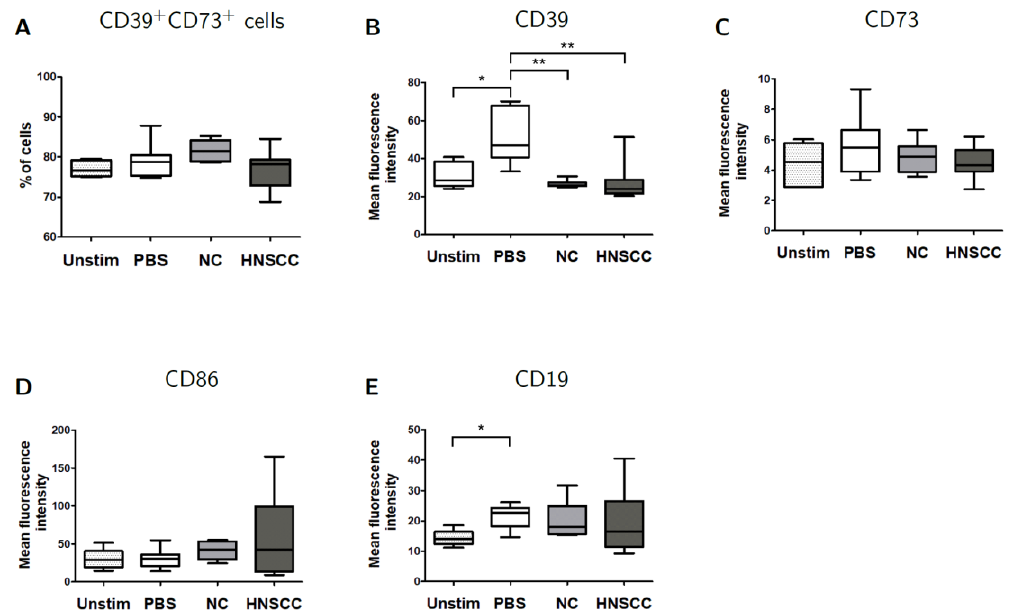
Figure 5. B cells were harvested after 2 days of co-culture with either NC or HNSCC exosomes or PBS and stained for FACS analysis. ( A ) Frequency of CD39 + CD73 + regulatory B cells. ( B ) The expression of CD39 on B cells was reduced after co-culture with NC or HNSCC exosomes. (C) Expression of CD73 on B cells. ( D ) Expression of CD86 on B cells. ( E ) The expression of CD19 on B cells was increased by stimulation with CD40L and IL-4. **: p < 0.01; *: p < 0.05, n = 8 (HNSCC), n = 6 (NC), n = 5 (Unstim). Unstim = Unstimulated B cells, NC = no cancer (exosomes from blood plasma of healthy volunteers), HNSCC, exosomes from blood plasma of HNSCC patients.